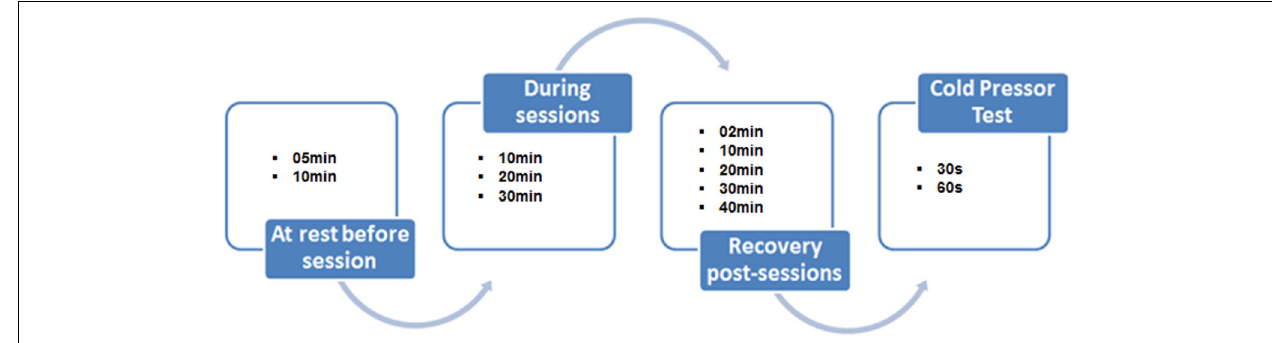
FIGURE 1 | Study design representing BP and HR measurements during sessions and when performing the Cold Pressor